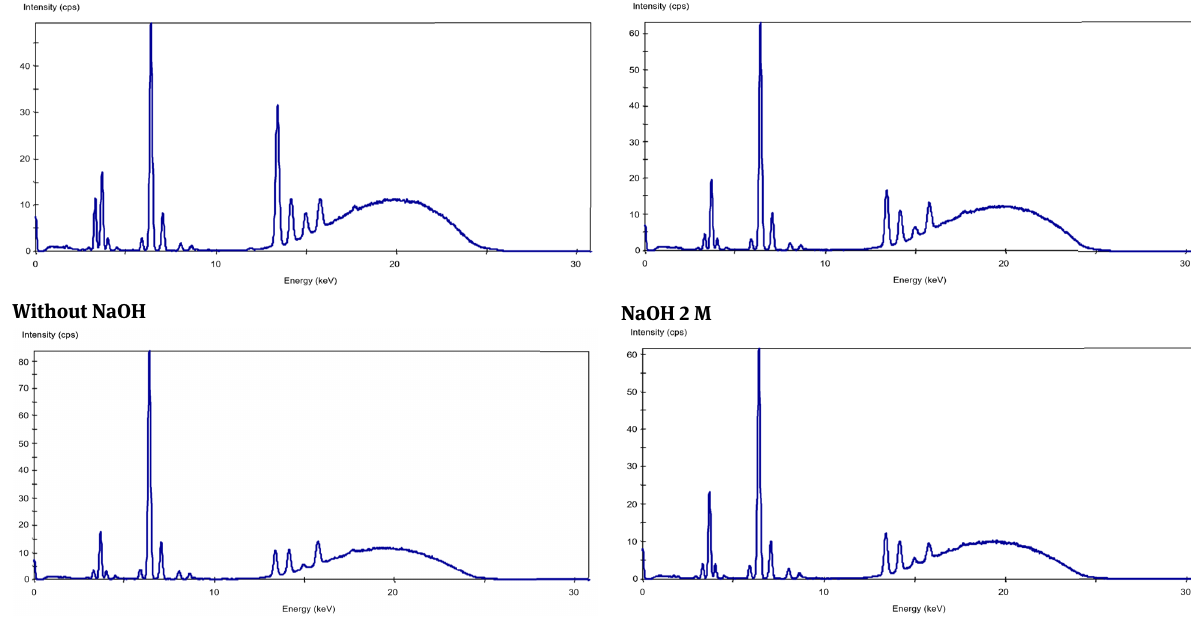
NaOH 2,5 Figure 3: OPBA nanoparticle XRF